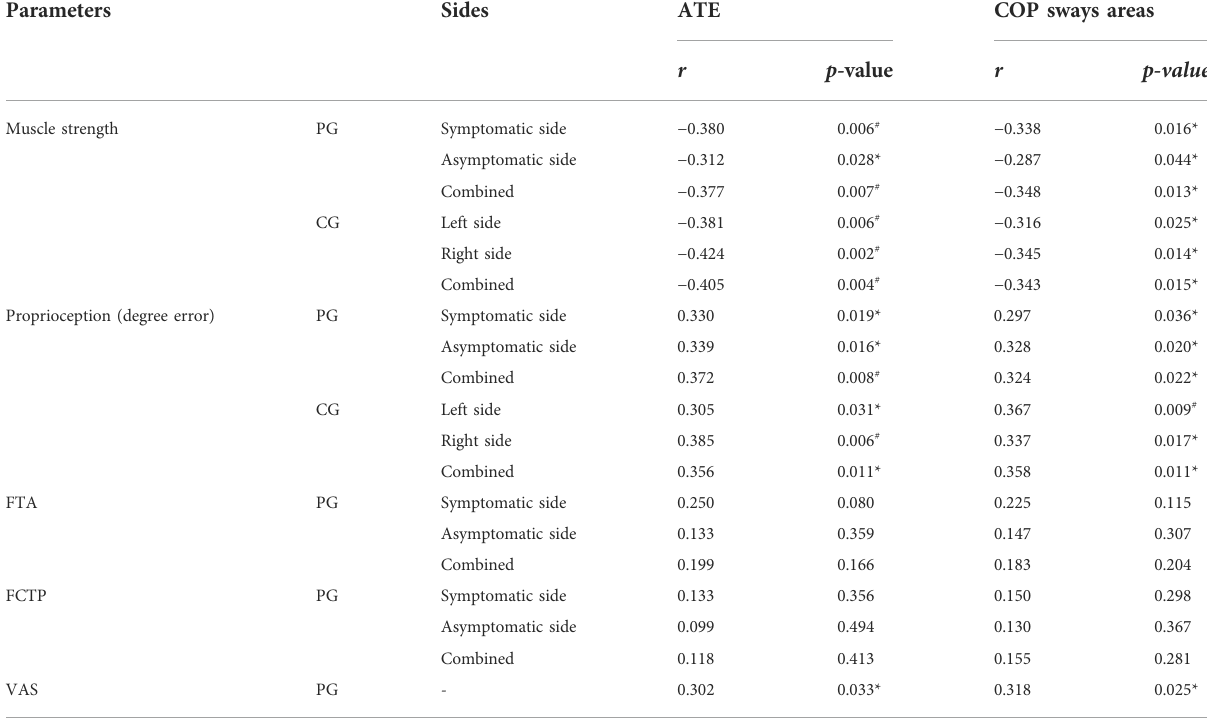
TABLE 3 Statistical analysis results of correlation